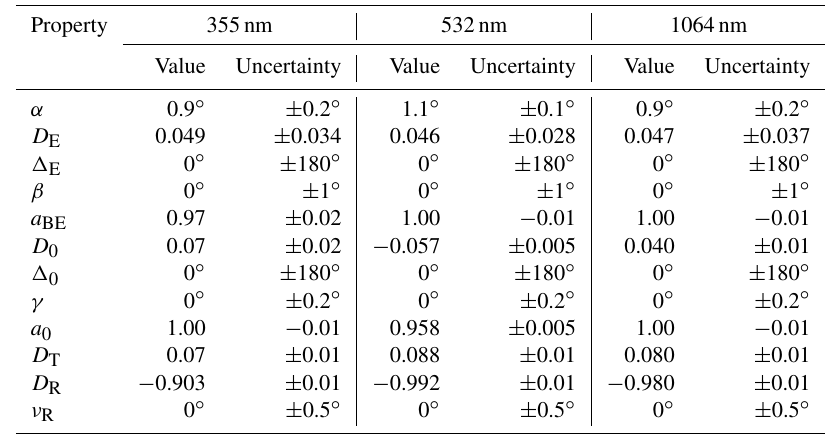
Table A1. BERTHA parameters (values) used in the volume depolarization-ratio retrieval and uncertainties. Each wavelength is treated separately: rotational misalignment of the laser ( α ), the emitting optics ( β ), the receiving optics ( γ ), and the cross-polarized receiver channel ( ν R ); diattenuation and retardation of the emitter optics ( D E , (cid:49) E ) and the receiver optics ( D 0 , (cid:49) 0 ); the diattenuation of the total and cross- polarized receiver channel ( D T , D R ); the degree of linear polarization of the beam expander ( a BE ) and the polarization parameter of the 90 ◦ mirror in the telescope ( a 0 ). Explanations for the parameters are given in the text. The configuration is given for SALTRACE-3 (summer 2014).